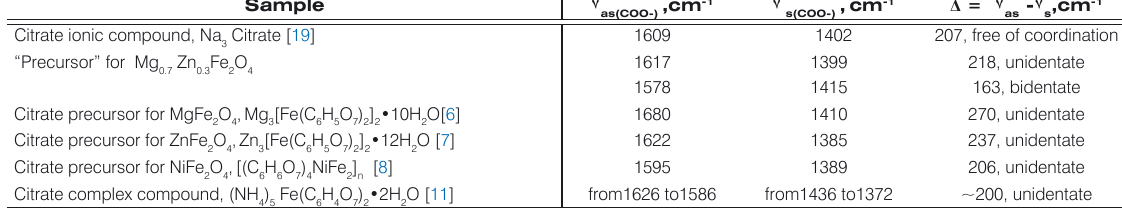
Table 1. Infrared data for citrate precursors, citrate ionic compound, and citrate complex compound